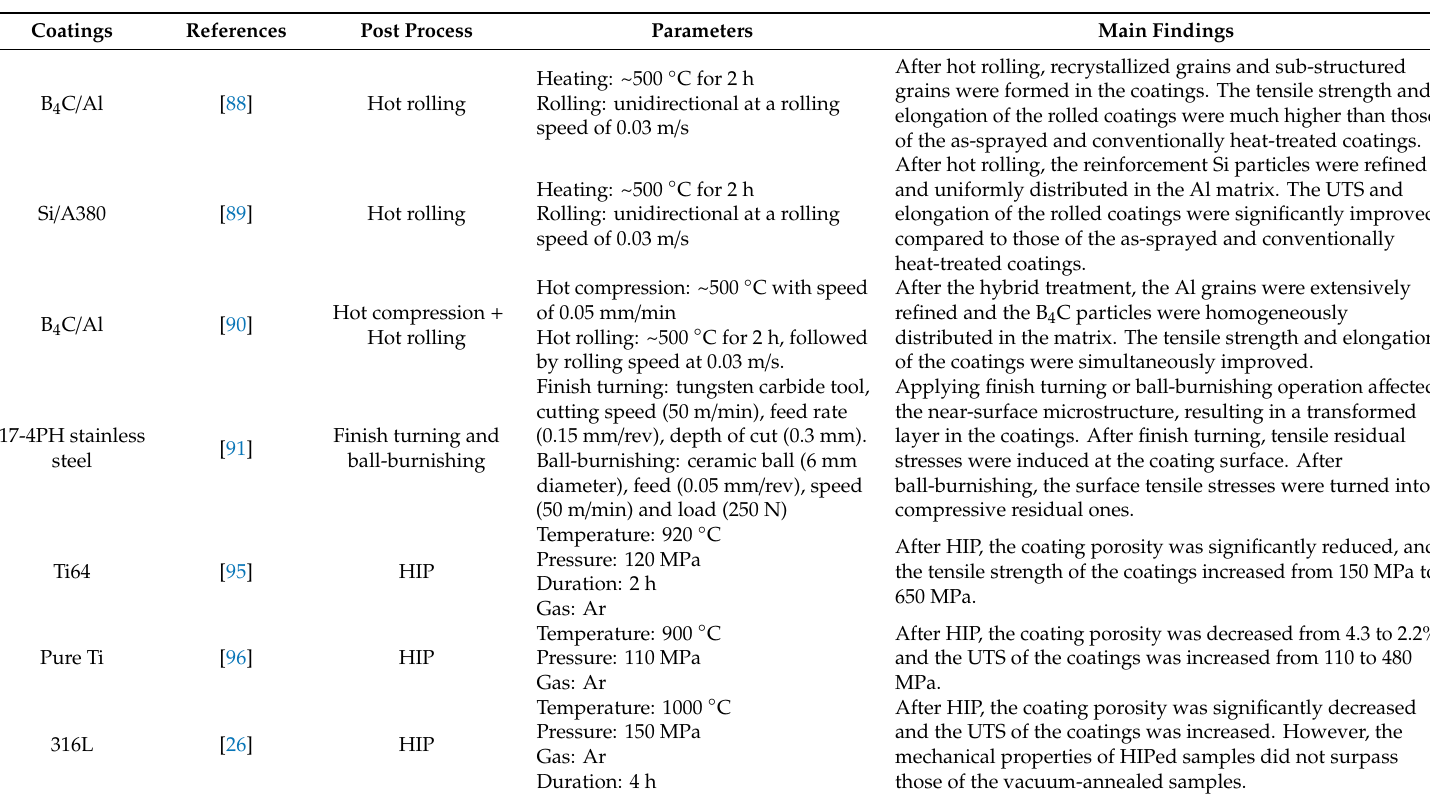
Table 6. E ff ect of other post treatments on cold sprayed